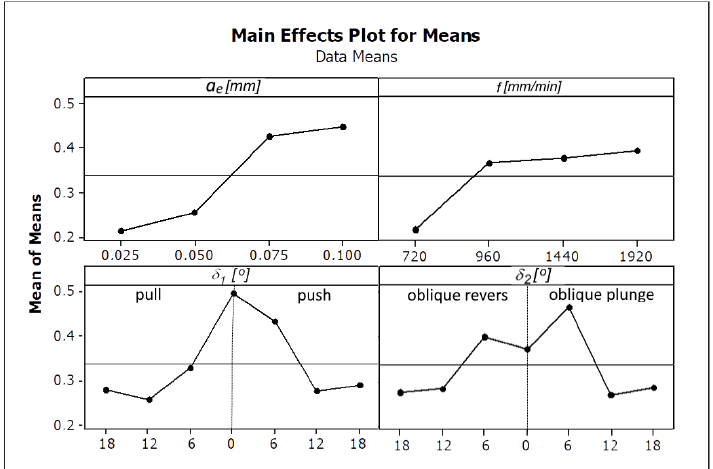
Figure 6. The influence of the analyzed factors on the means values of the surface roughness parameter Ra.